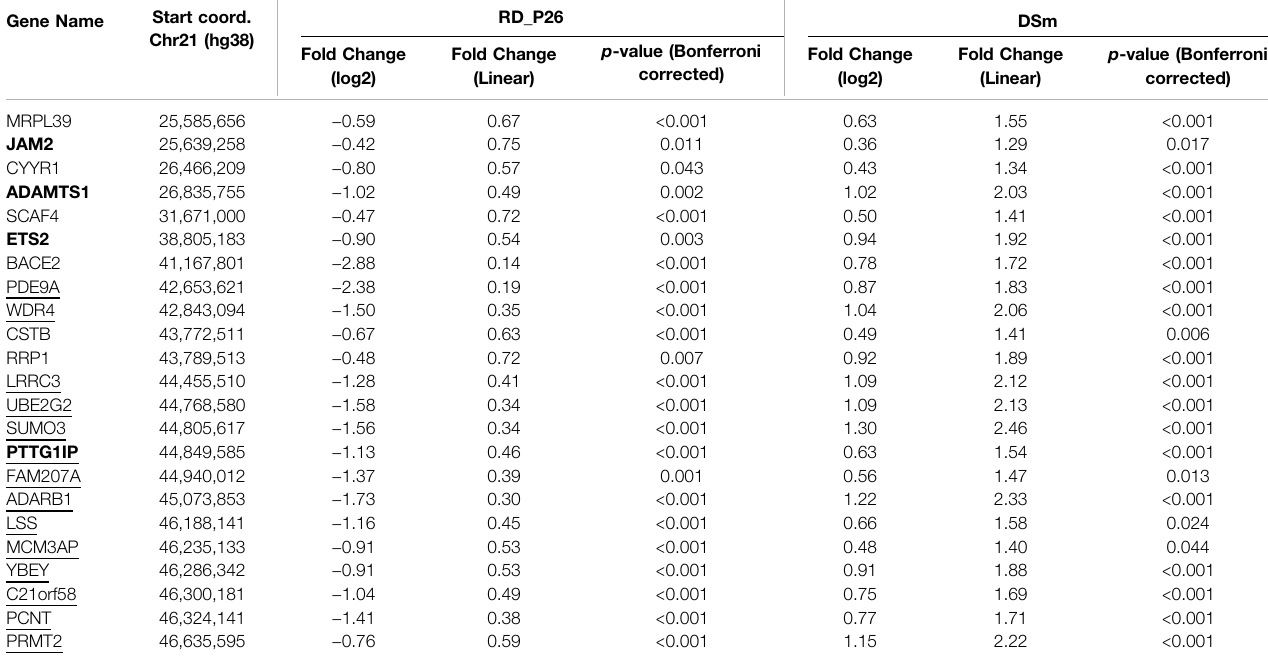
FIGURE 4 | labelled with the respective gene names. Note that all mirrored genes of DSm and RD_P26 are all upregulated and downregulated, respectively, and thereforelocateaboveandbelowthelimitfordifferentialexpression( ± 25%) (D) Venndiagramsprovidingnumbersforsigni fi cantlyanddifferentiallyexpressed(left)genes in RD_P26 (red) and DSm (green) and mirrored expression (right) for shared genes, displayed for genome-wide, chromosome 21 and the two deletions. The size of circles is not to